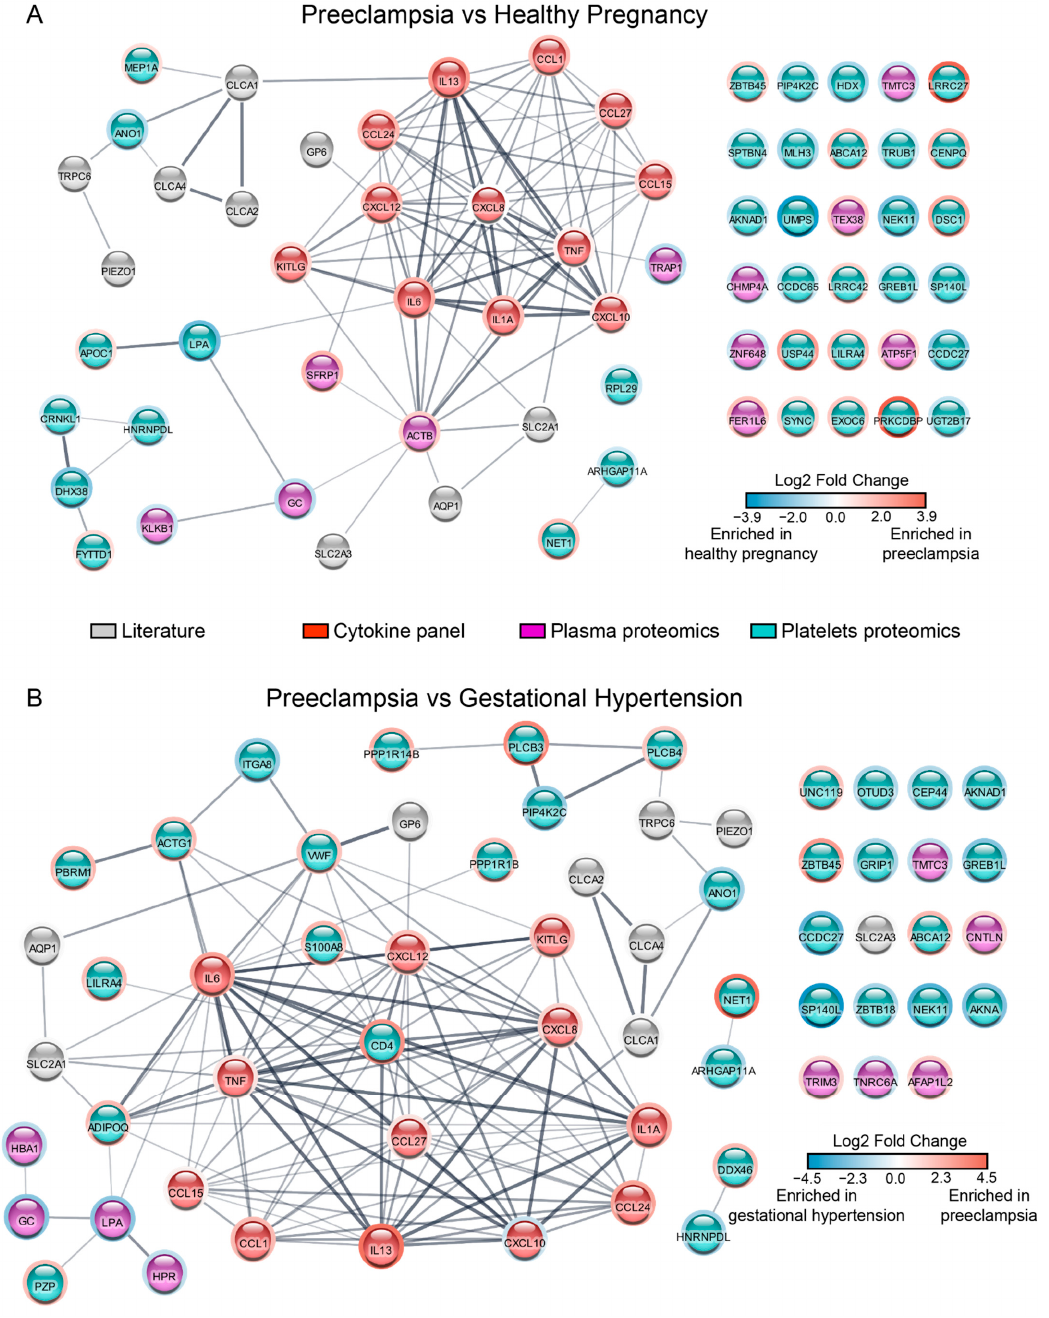
Figure 5. Integrative analysis represented by protein-protein interaction network. Preeclampsia vs. healthy pregnancy ( A ), and preeclampsia vs. gestational hypertension ( B ). Plasma and platelet proteomics are represented by differently expressed proteins as determined by boxplot. All cytokines and chemokines were included. Additional proteins were selected from the literature, including solute carrier family 2—facilitated glucose transporter member 1 (SLC2A1, i.e.,: GLUT1), -3 (SLC2A3, i.e.,: GLUT3), aquaporin-1 (AQP1), piezo-type mechanosensitive ion channel component 1 (PIEZO-1), short transient receptor potential channel 6 (TRPC6), Calcium-activated chloride channel regulator 1 (CLCA1), -2 (CLCA-2), -4 (CLCA-4), and platelet glycoprotein VI (GP6). Each node was colored according to its data source: literature = grey, cytokine and chemokines = red, plasma proteomics = magenta, and platelets proteomics = teal. The border color of each node changes according to the fold change; red is enriched in preeclampsia, and blue is enriched in either healthy pregnancy ( A ), or gestational hypertension ( B